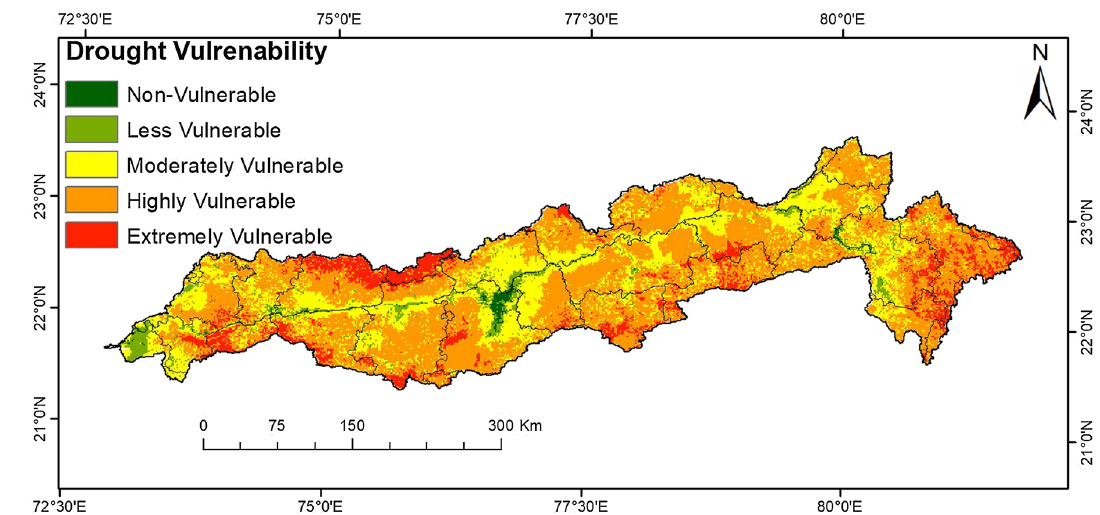
Fig. 12 Classification of Narmada Basin into different vulnerability categories based on